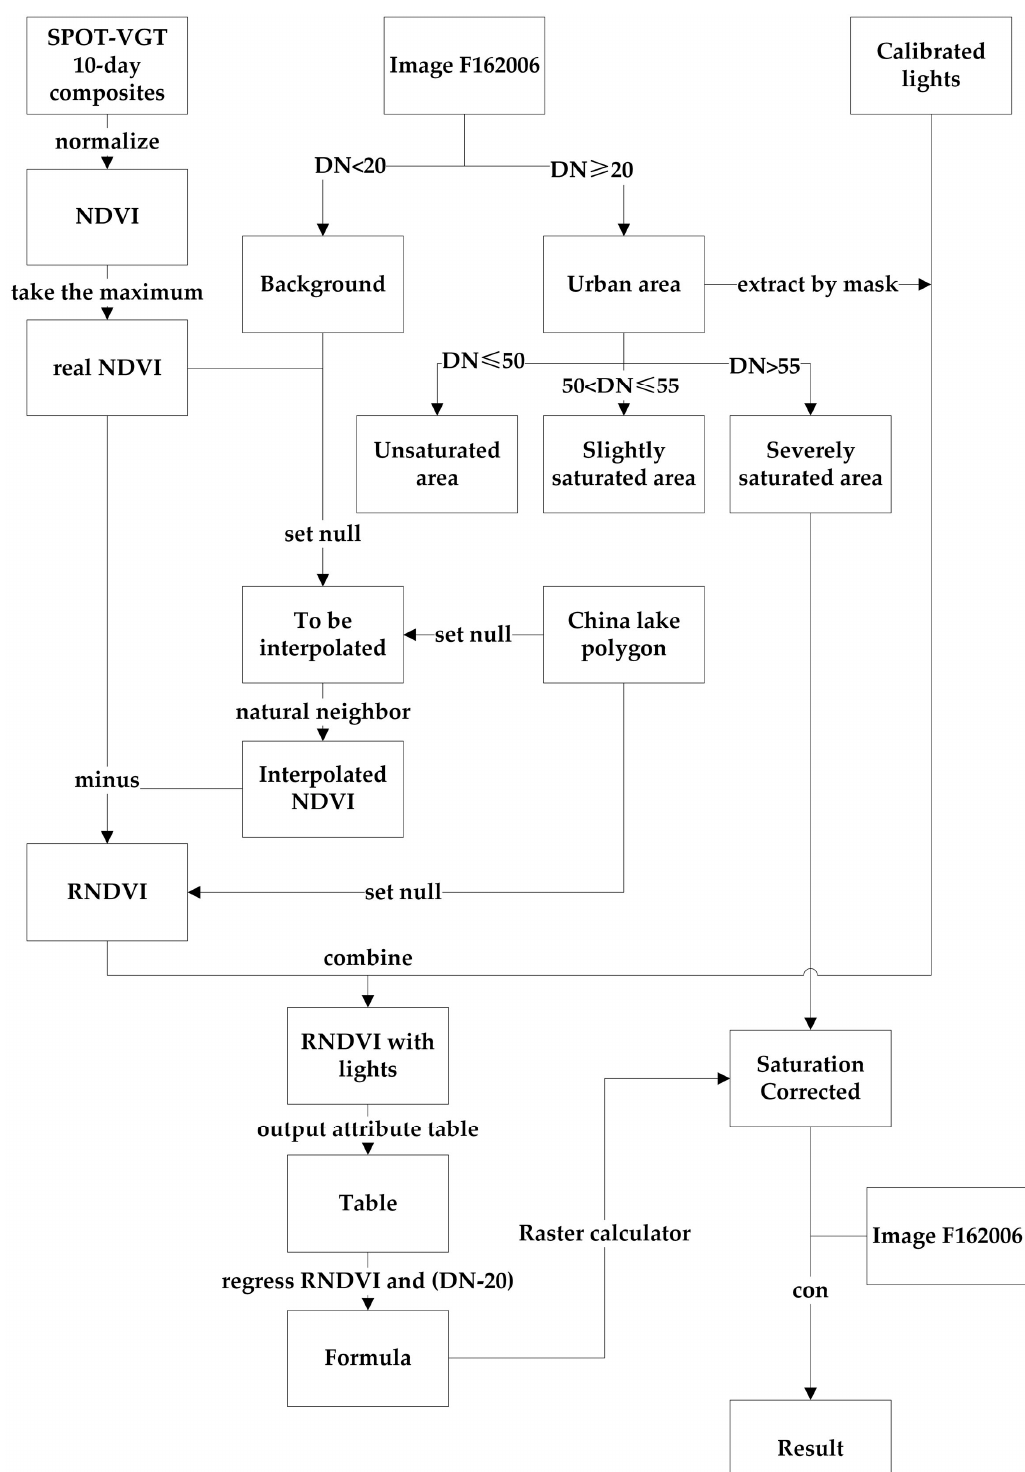
Figure 5. Flowchart of the proposed method.